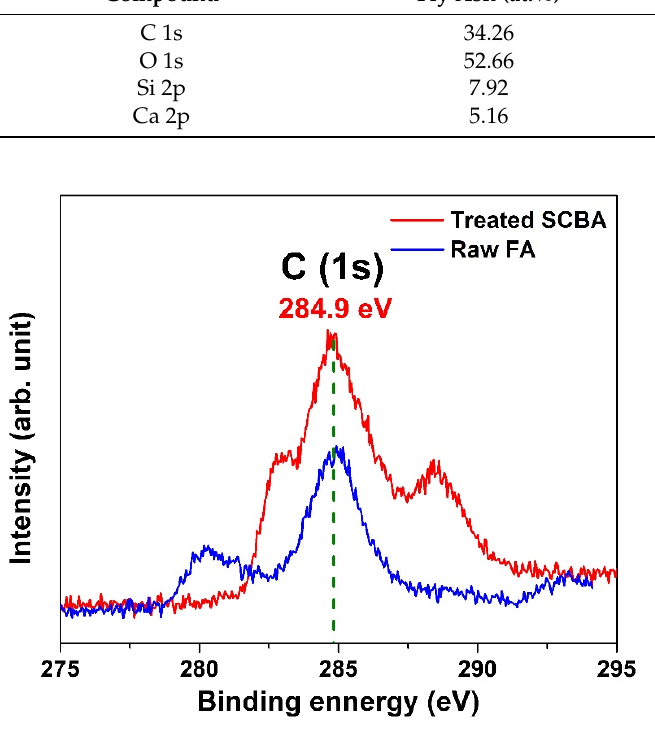
Figure 9. The carbon (1S) XPS spectra of the raw FA and the treated SCBA powders.